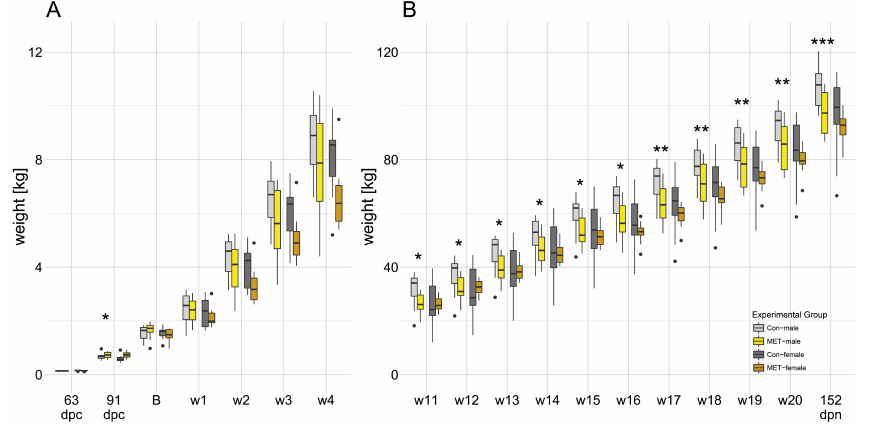
Figure 2. Box plots representing fetal weights and live weights in progeny exposed to maternal CON and MET diets. Data recorded ( A ) at fetal stages display individual experiments. Data recorded from ( A ) birth to week 4 (28 dpn), ( B ) from week 11 (77 dpn) to week 20 (140 dpn), and at 152 dpn represents a time course. Fetal weight was increased in MET-males at 91 dpc. Live weight was lowered in MET-males from week 11 (77 dpn) until 152 dpn. CON—Standard diet; MET—Standard diet supplemented with methylating micronutrients; CON-males: light gray ; CON-females: dark gray ; MET-males: yellow ; MET-females: orange ; * p ≤ 0.05; ** p ≤ 0.01; *** p ≤ 0.001; dpc—days post conception; dpn—days post